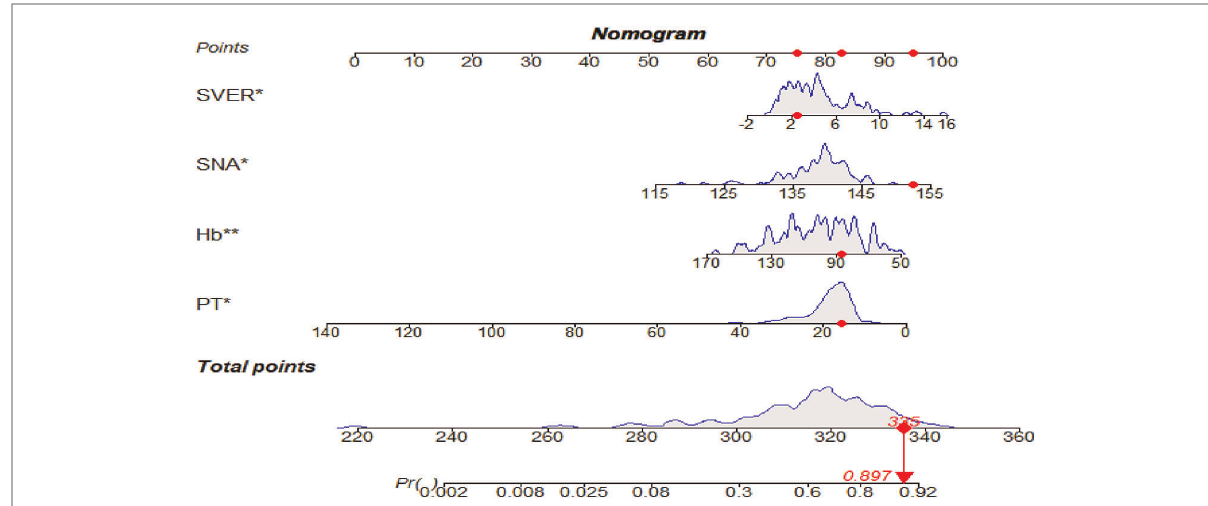
FIGURE 2 The nomogram for predicting the bleeding risk of esophagogastric varices in patients with hepatitis B cirrhosis. A 59-year-old male patient with hepatitis B cirrhosis for 20 years. The total score and the density map of SVER, SNA, Hb, and PT are shown. The importance of each variable is ordered according to the standard deviation on the nomogram scale. To use the nomogram, individual patient-speci fi c points (red dots) are located on each variable axis. Mark the red dots on the points axis to determine the number of points each variable received; the sum of these points (335) lies on the total points axis. Draw a line down to the probability axis to identify the probability of esophagogastric variceal bleeding (89.7%).